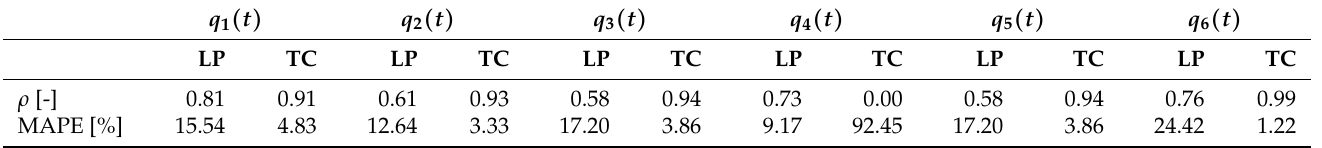
Table 1. Correlation coefficient ρ and MAPE of ALPR (abbreviation LP), thermal camera data (abbreviation TC) and the 10 min MA Ground Truth flow